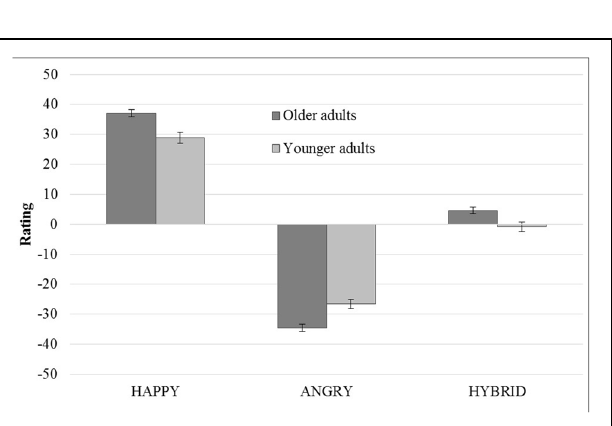
a line presented horizontally in the center of the screen), how positive or negative the face seemed by moving a slider along the line with the mouse. The line represented a